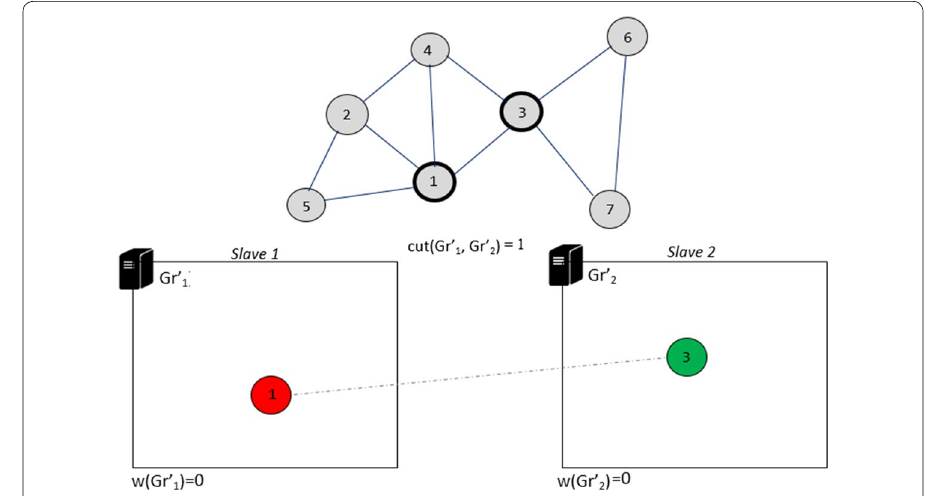
Fig. 8 Iteration 1 of DPHV